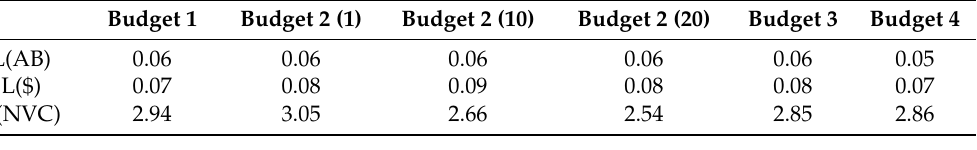
Table 5. Leverage metric summary.